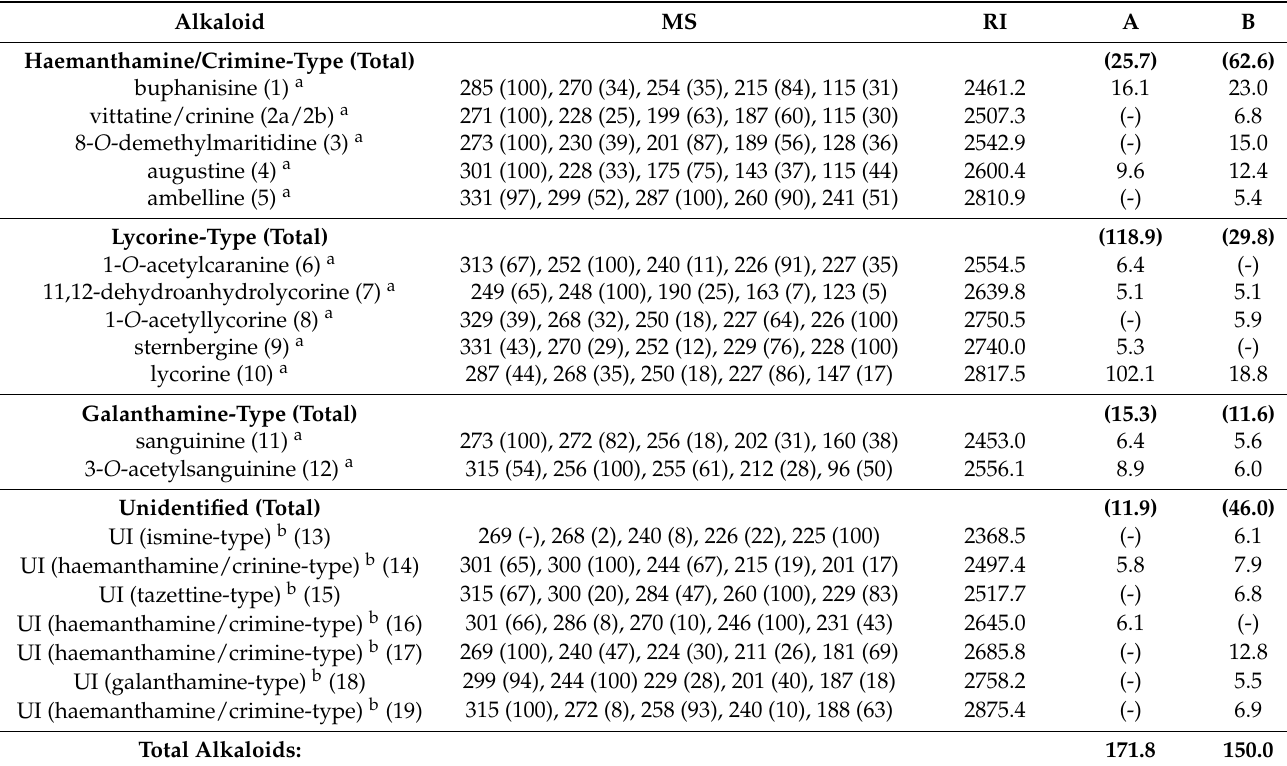
Table 1. GC-MS alkaloid profiling of Crinum × amabile collected in Ecuador. Values expressed as mg GAL · g − 1 AE. Alkaloid